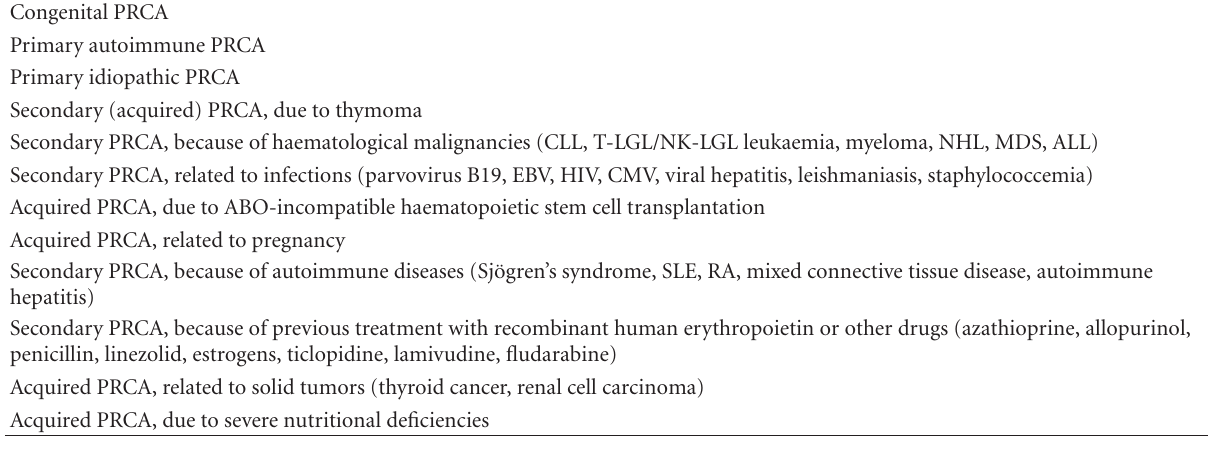
Table 1: Classification of PRCA [2, 5].